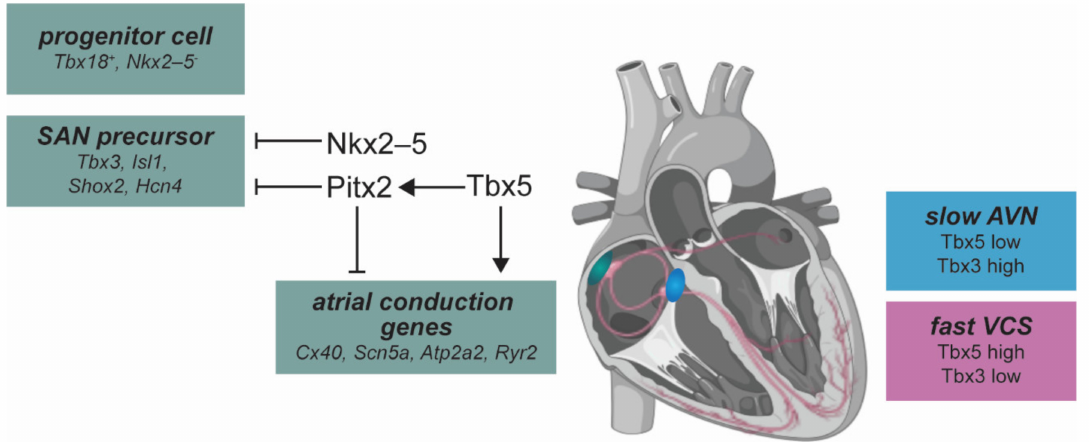
Figure 2. Overview of molecular pathways in the mammalian cardiac conduction system. The sinoatrial node (SAN, green) develops from Tbx18 + , Nkx2-5 low progenitor cells. Nkx2-5 represses expression of Tbx3 and Isl1 to establish the boundary between the SAN and atrial cardiomyocytes. SAN precursor cell differentiation is marked by expression of Tbx3, Isl1, Shox2, and Hcn4. Pitx2 represses SAN development on the left side of the sinus venosus by repressing this transcriptional network. The Tbx5 (activator) and Pitx2 (repressor) regulatory loop regulates atrial conduction genes. Relative Tbx3/Tbx5 dosage determines specification of the conduction system. The atrioventricular node (AVN, blue) acts as a secondary pacemaker, and is characterized by slow conduction that is patterned by low levels of Tbx5 and high levels of Tbx3. A fast conduction state in the ventricular conduction system (VCS, pink) is specified by higher levels of Tbx5 and low